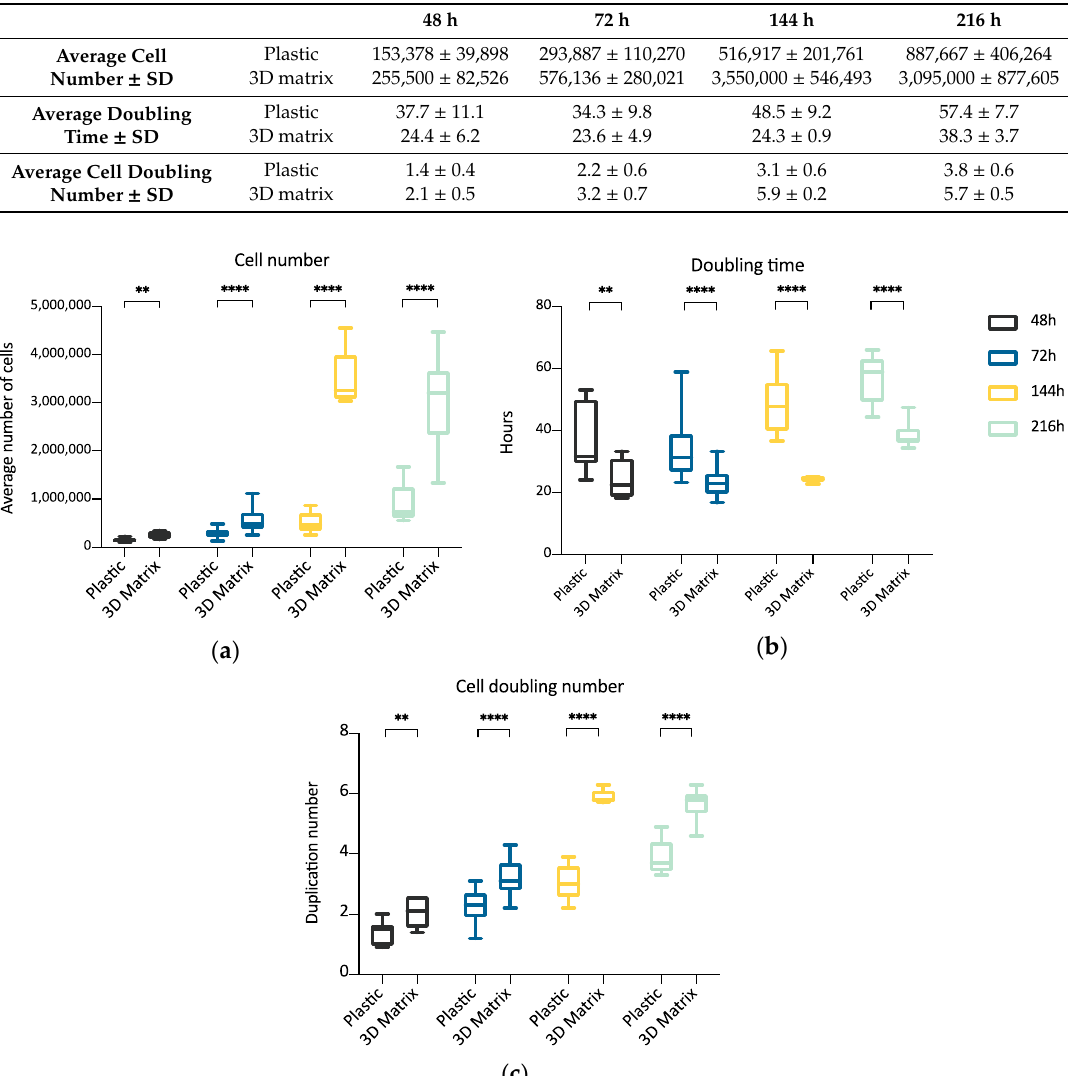
Table 1. Average cell number, doubling time and cell doubling number ± SD obtained at di ff erent time points (48, 72, 144, 216 h) from ADMSCs cultured on 2D plastic surface or 3D fibrin-based gel prepared from PPP (n = 5). Cells were seeded at a density of 6000 cells / cm 2 in 3.5 cm Petri dishes. 48 h 72 h